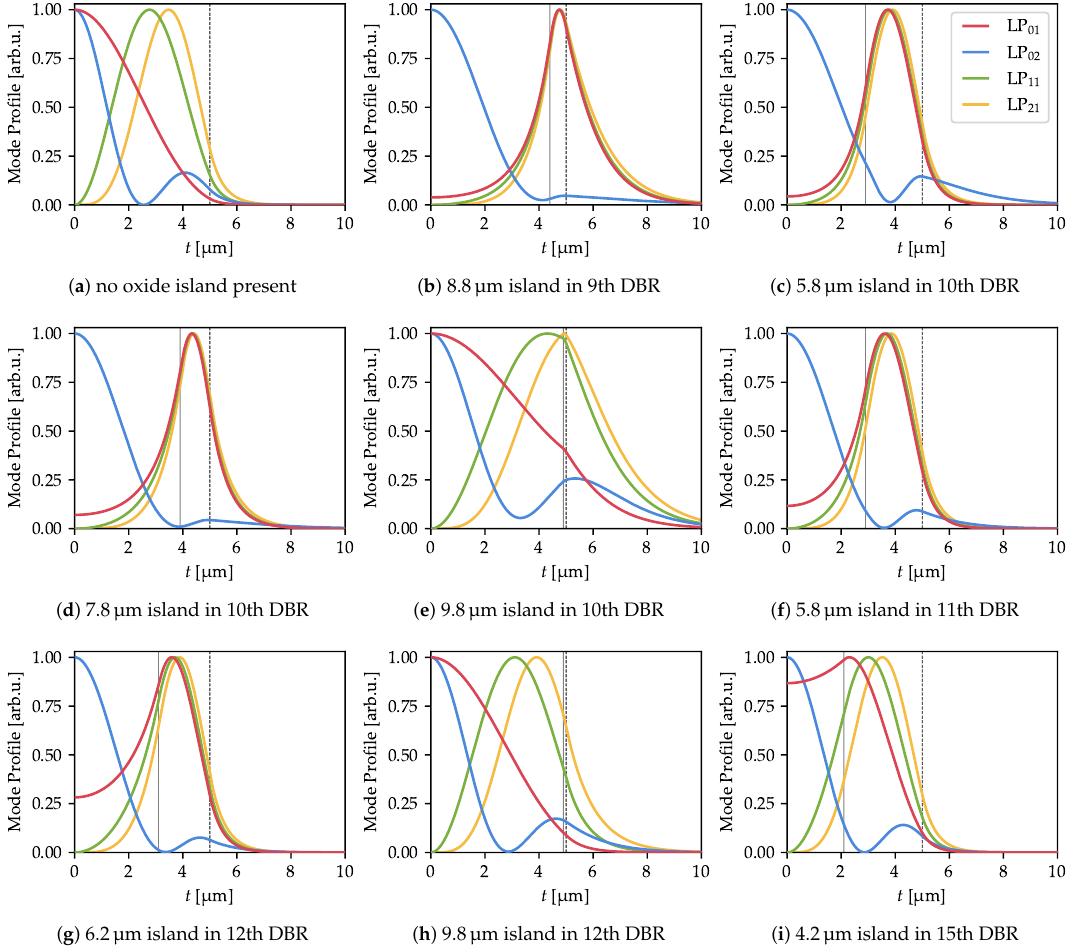
Figure 8. Light intensity profiles for selected island positions and sizes. Dashed vertical black lines indicate the outer aperture radius, while the solid gray line shows the island aperture radius. In points where LP 02 has a low threshold current, it is mostly located near the device axis. When it has a strong second-order peak its threshold